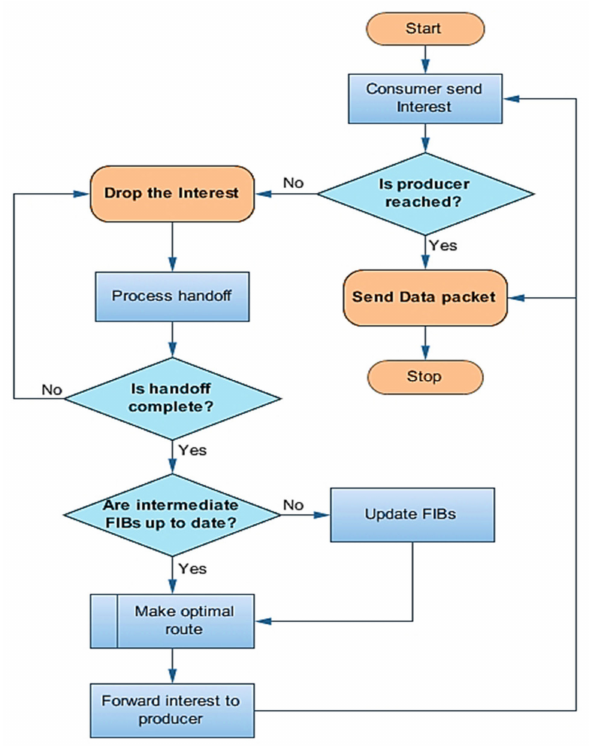
Figure 4. Interest packet transmission in